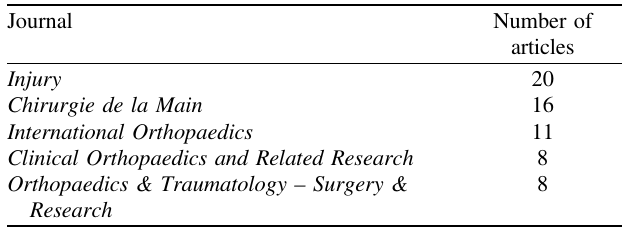
Table 1. Top fi ve orthopaedic journals with most publications coming from LICs, 2007 – 2017.